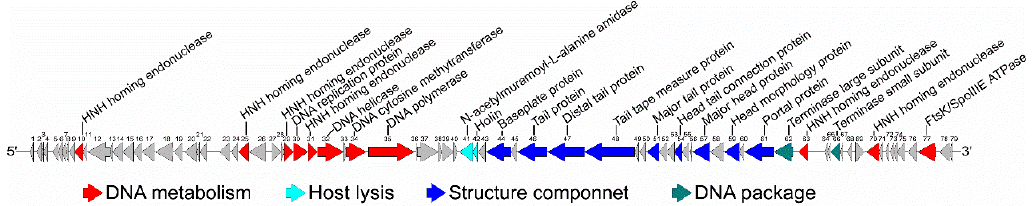
Figure 2. Schematic diagram of the genome of the phage vB_BthS_BMBphi. The functional classification of the genes in the phage vB_BthS_BMBphi genome are indicated in different colors and the transcription directions of the genes are also shown.